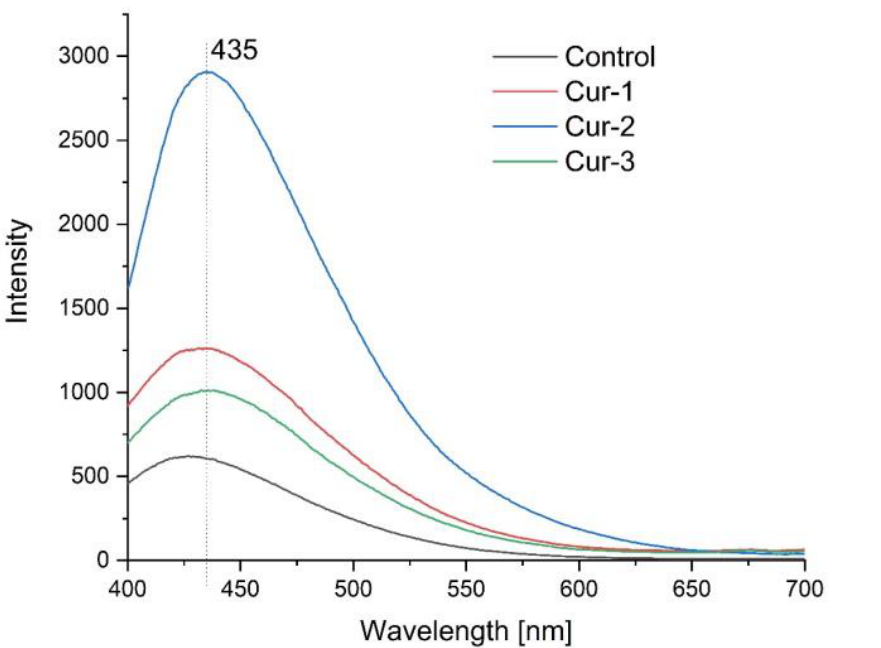
Figure 4. Emission spectrum of the resulting composites.